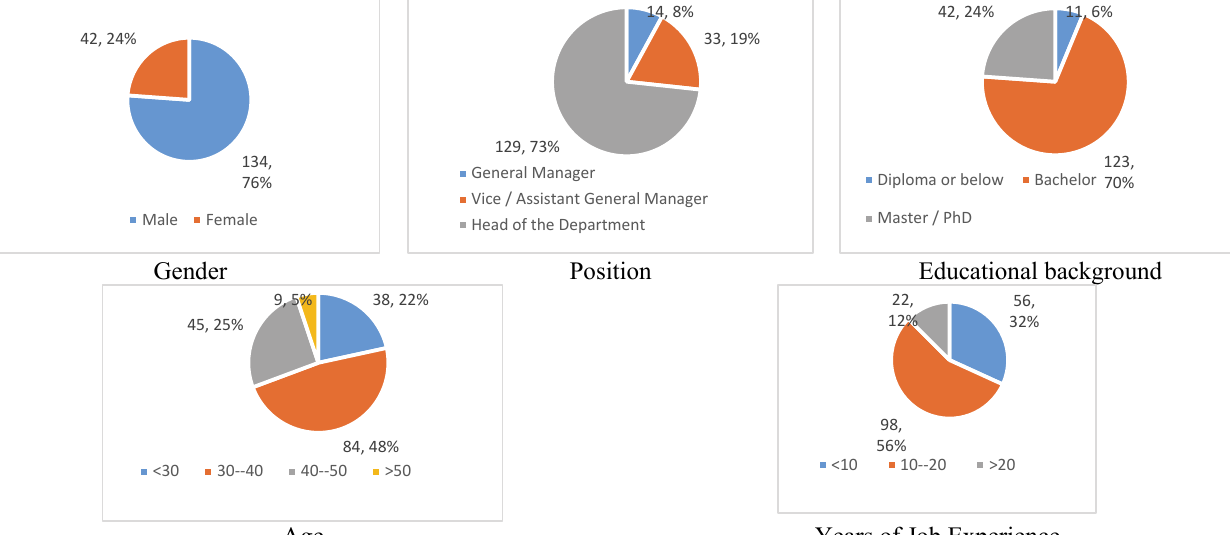
Fig. 1. Personal characteristics of the